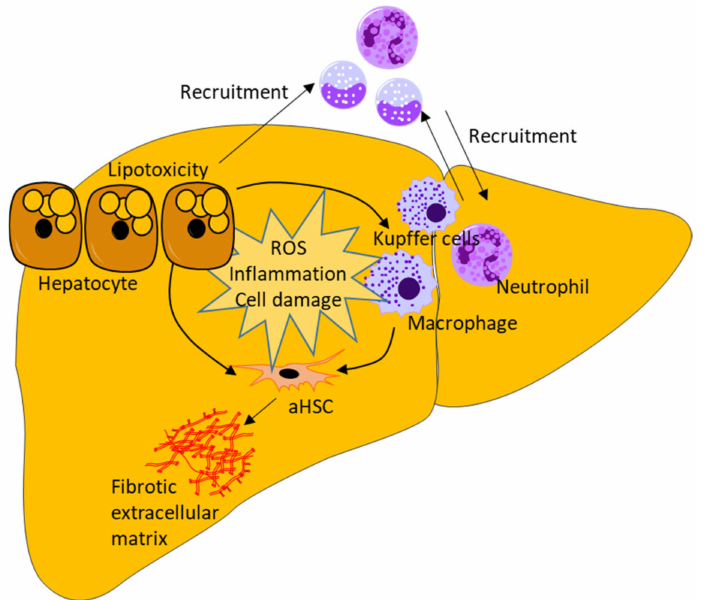
Figure 1. A simplified overview of primary drivers of non-alcoholic steatohepatitis (NASH)-induced hepatic fibrosis. The excessive accumulation of triglycerides and free fatty acids increases hepa- tocellular lipid oxidation generating reactive oxygen species (ROS) and lipotoxicity. This leads to cellular damage and the release of inflammatory cytokines, prompting the activation of resident liver macrophages (Kupffer cells) and the recruitment of circulating immune cells: monocytes and leukocytes. The initial hepatic steatosis then becomes a state of hepatic inflammation and